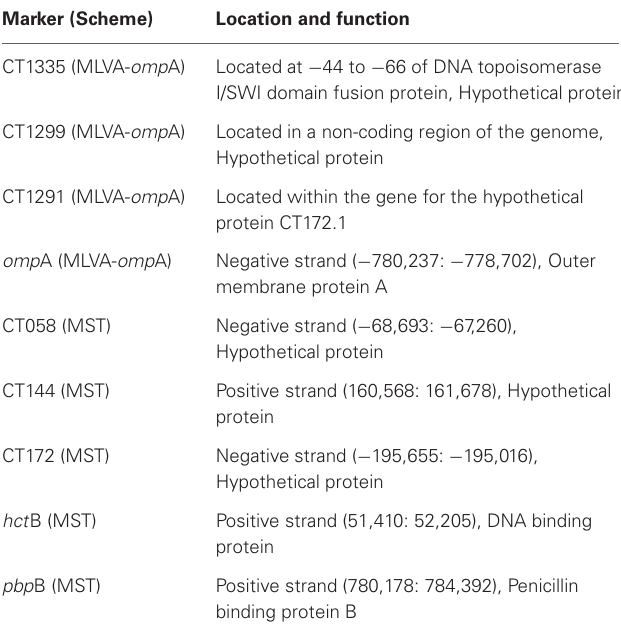
Table 2 | Location and putative function of the MLVA- omp A and MST markers within the genome, also included is the strand (negative or positive) in which the MST and omp A markers are